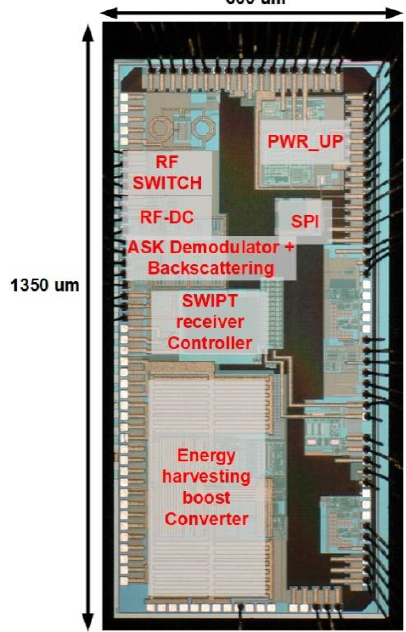
Figure 17. Chip photograph of the SWIPT IC.